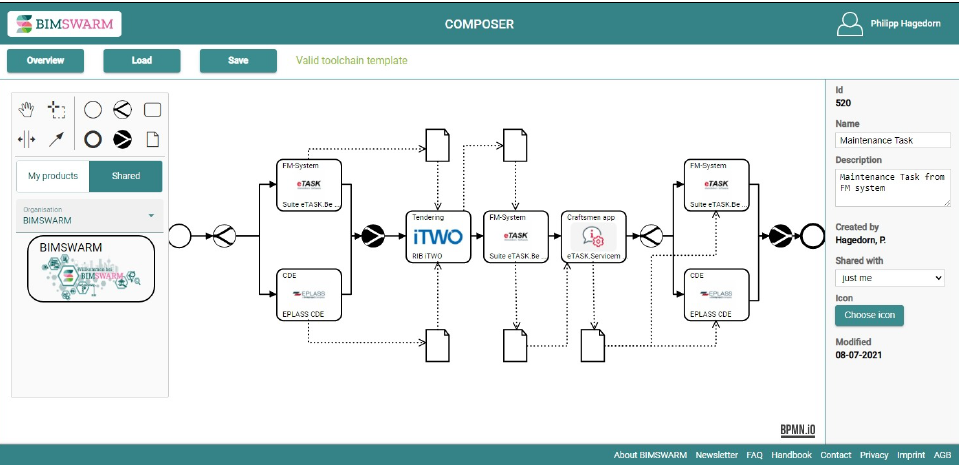
Figure 10. Modeled toolchain in the Composer on the BIMSWARM platform for the use case maintenance